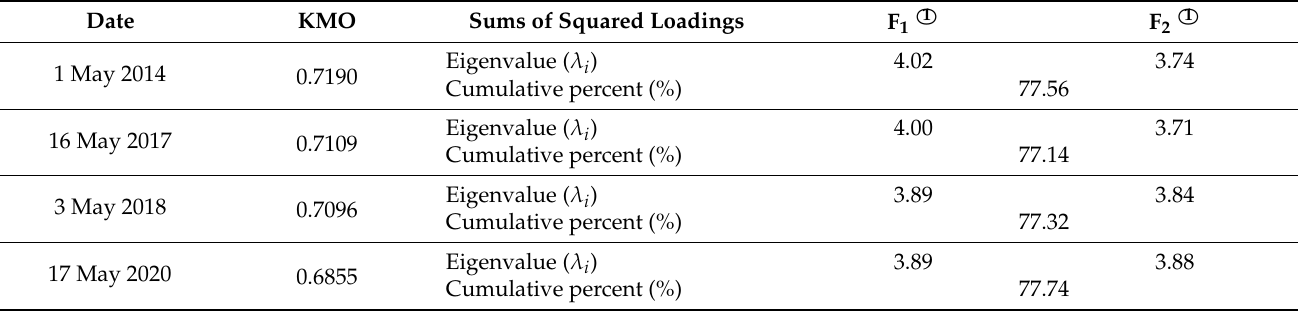
Table 6. Total variance explained from principal component analysis (PCA).